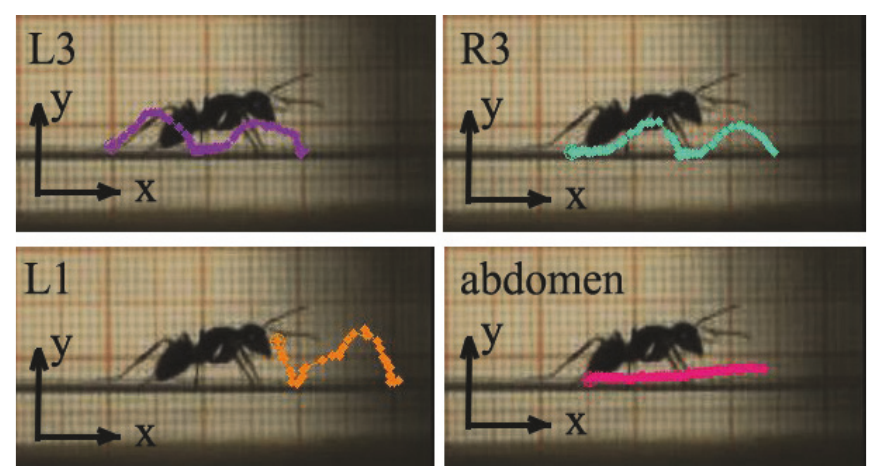
Figure 7: The trajectories of the foot end of L1, R3, and L3 and the tip of the